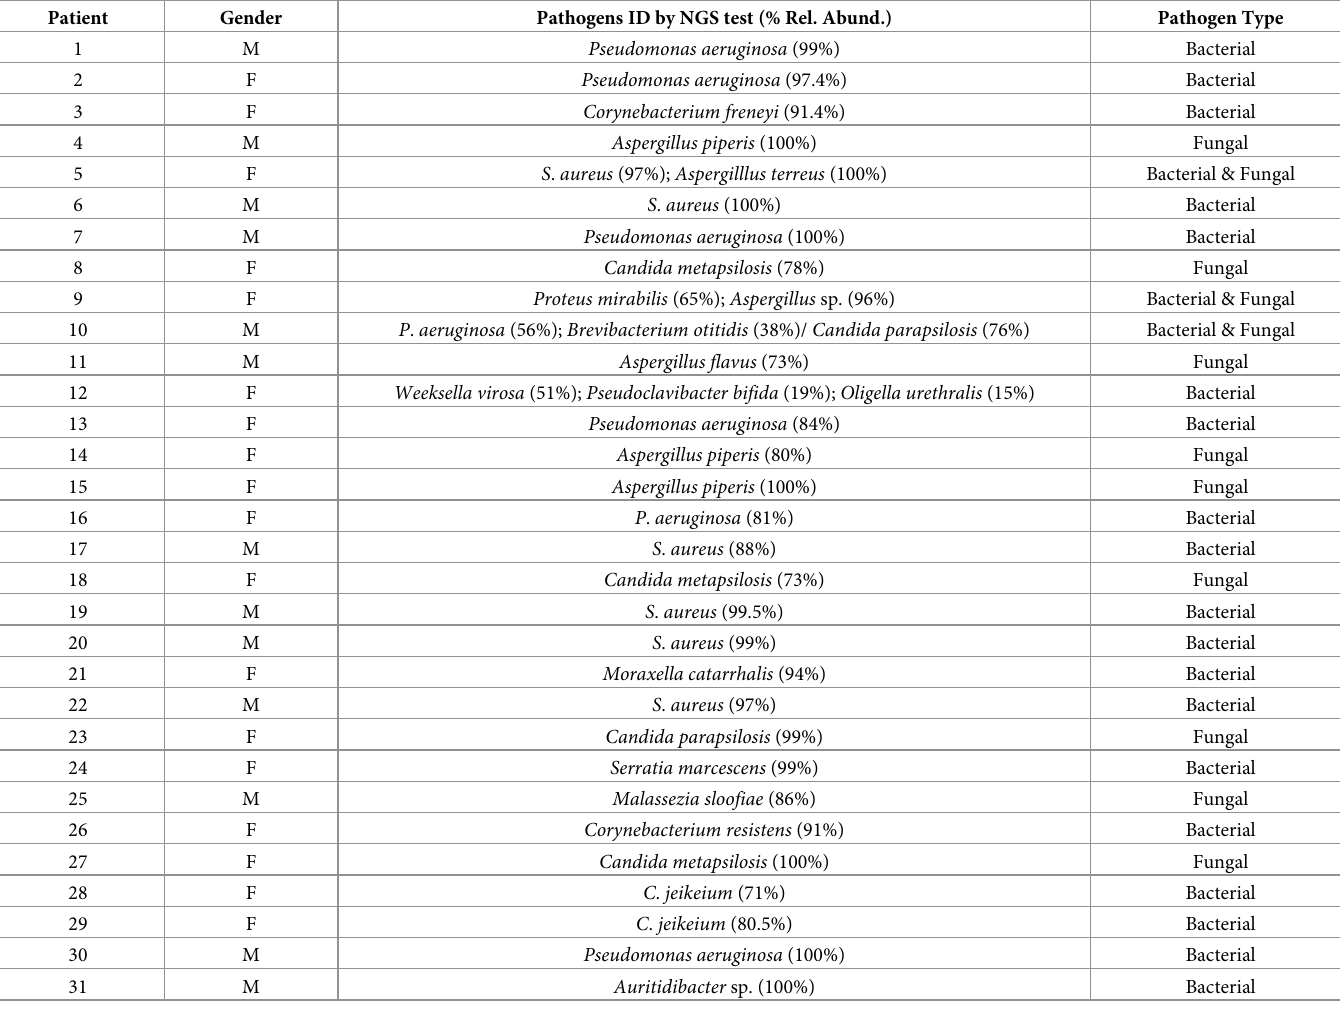
Table 3. Pathogens detected in otitis media (OM) patients at high relative abundances.